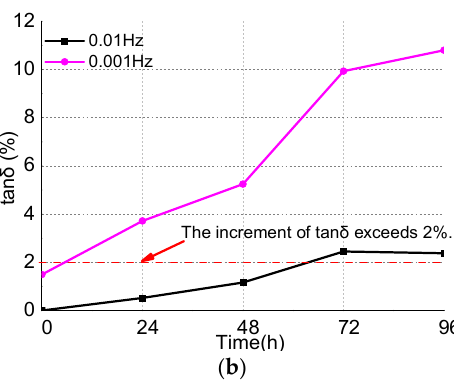
Figure 12. Increment of tanδ. ( a ) Increment of tanδ at the voltage from 10 kV to 1.2 U m ; ( b ) Increment of tanδ at 0.001 Hz and 0.01 Hz.